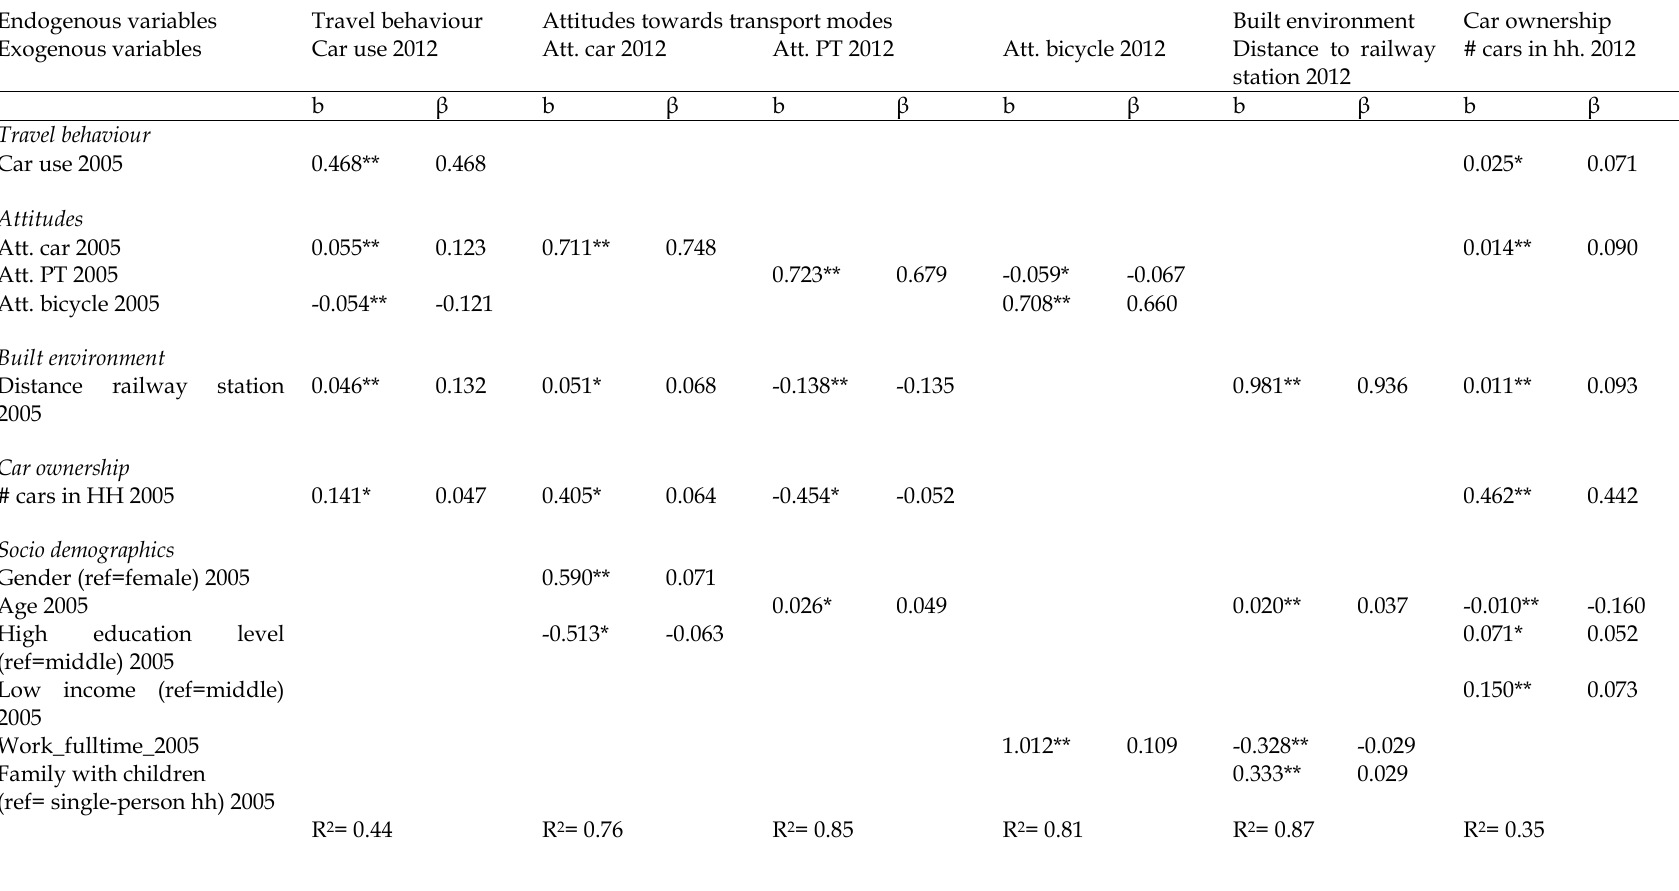
Table 3. Model 2 with car ownership and controls for socio-demographics